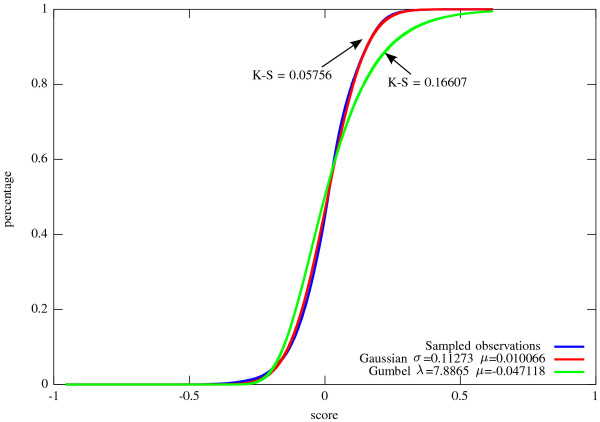
The result of runningStats(D,1 × 106) inUU mode ofHSA with relative score and its fitting to Gaussian distribution.